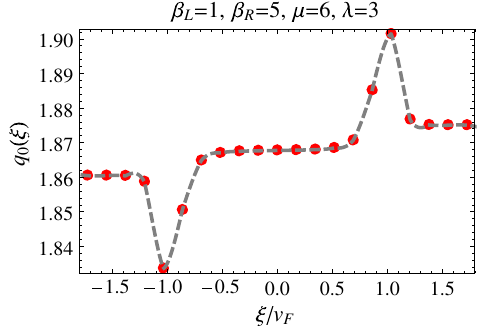
FIG. 10. Effective velocity in the sinh-Gordon model for ξ ¼ 0 . FIG. 8. A characteristic profile of the Lieb-Liniger particle Displayed are the effective velocity v eff ð θ Þ (blue line) and the ≪ μ , λ ¼ 3 , and μ ¼ 6 . The local maxima and density for T L;R bare relativistic velocity tanh θ (red minima are located around ξ ¼ (cid:4) v . The dashed curve is an F interpolation.